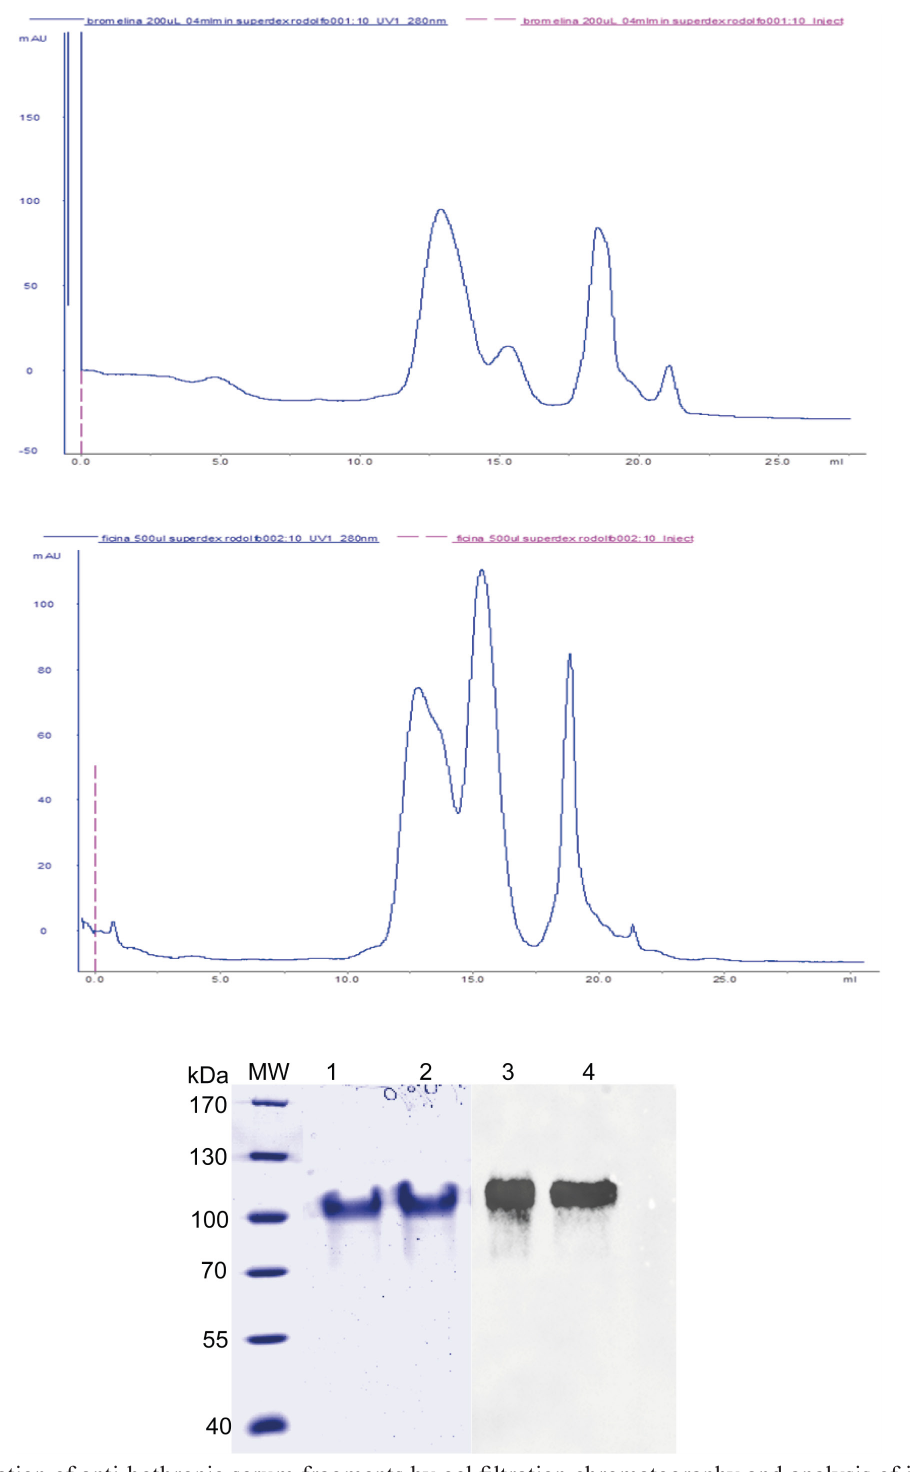
2 fragments are 2